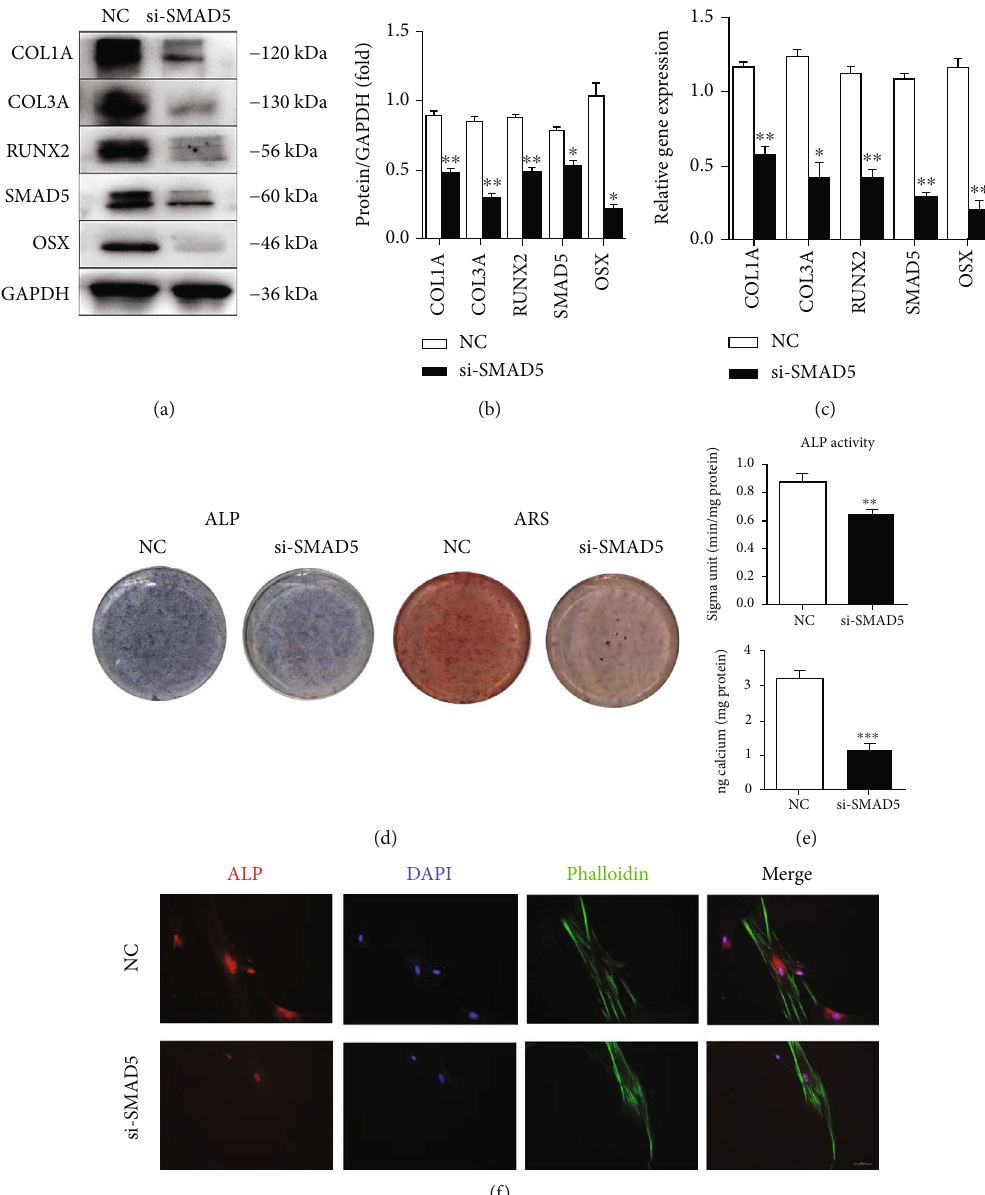
Figure 4: SMAD5 regulates the osteoblastic di ff erentiation ability of PDLSCs. (a) – (c) Western blot and RT-qPCR showed that osteogenic markers (RUNX2, OSX, COL1A, and COL3A) were downregulated in the SMAD5 siRNA-treated PDLSCs (si-SMAD5 group). (d, e) Silence of SMAD5 reduced the ALP activity of PDLSCs 7 days after osteogenic induction. ARS showed the mineralization of PDLSCs was decreased signi fi cantly in the si-SMAD5 group after osteogenic induction for 14 days. (f) Immuno fl uorescence experiments con fi rmed the decreased expression of ALP in the si-SMAD5 group. ∗ P < 0 : 05 , ∗∗ P < 0 : 01 , and ∗∗∗ P < 0 : 001